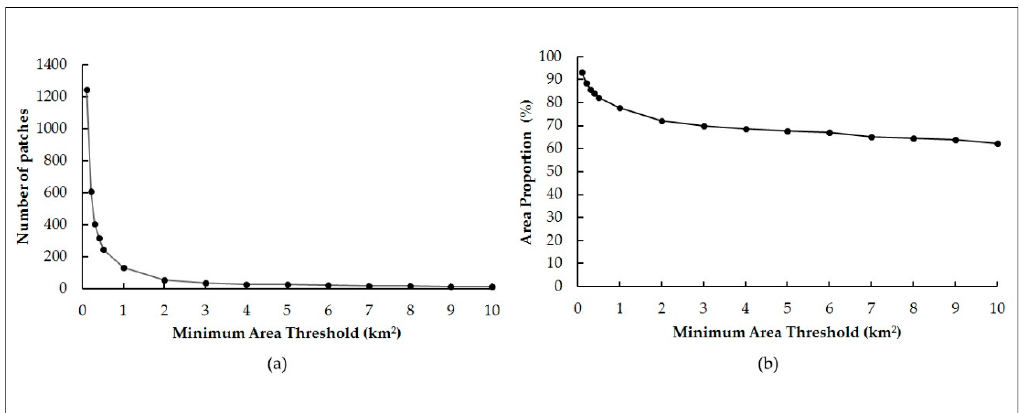
Figure 5. Influence of the threshold setting of the area of ecological source: ( a ) Correspondence between the minimum area threshold and the number of patches; ( b ) Correspondence between the minimum area threshold and area proportion.